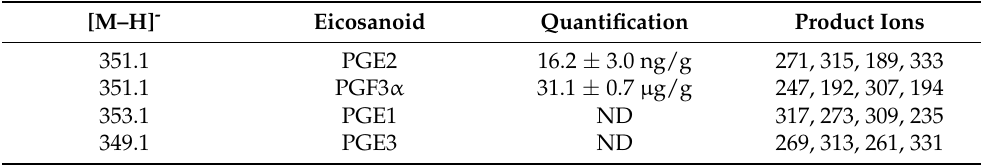
Table 2. Identification and quantification of eicosanoids in salmon muscle tissue.